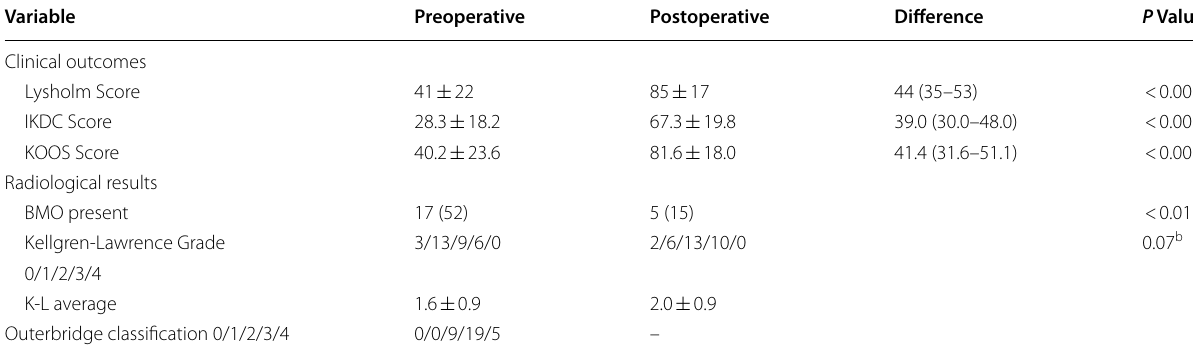
Clinical outcomes are presented as the mean Oedema, expressed as n (%) IKDC International Knee Documentation Committee, KOOS Knee Injury and Osteoarthritis Outcome Score a Wilcoxin signed-rank test b Fisher exact test; K-L grades were grouped as < 2 and